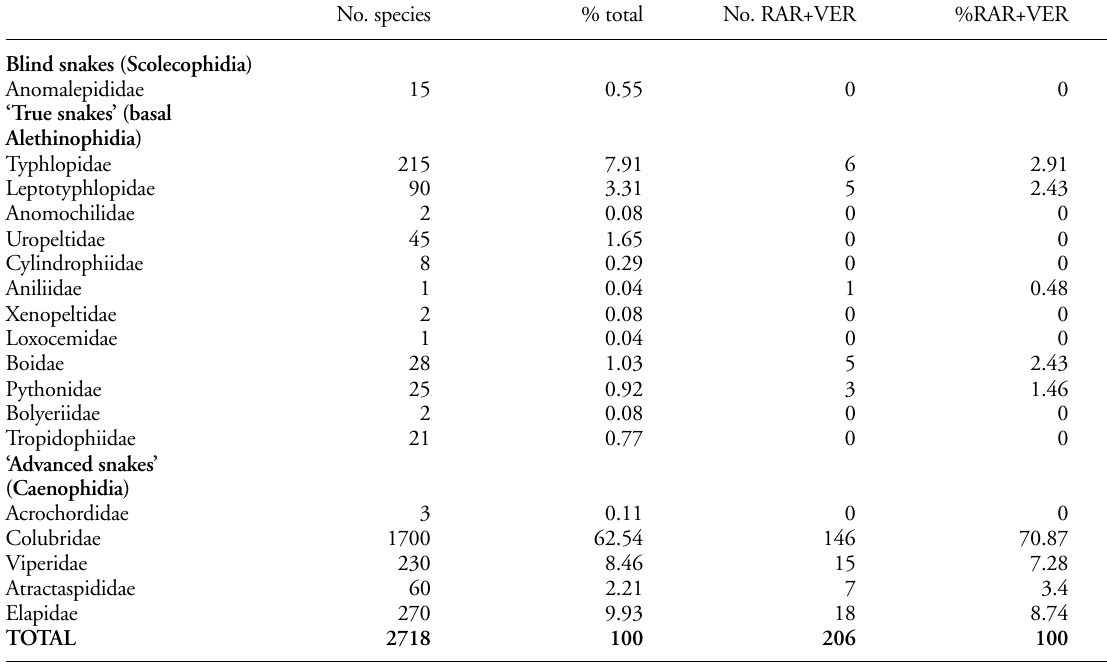
Table 2. Absolute numbers and relative frequency of occurrence (%) of rare species (RAR + VER) divided by family, as found in the studies reviewed in this article, and compared to the absolute numbers of known species (and their relative % frequency of occurrence) of the corresponding family throughout the world. Data on the numbers of world’s described species divided by family came from Halliday and Adler (2002). No. species % total No. RAR+VER